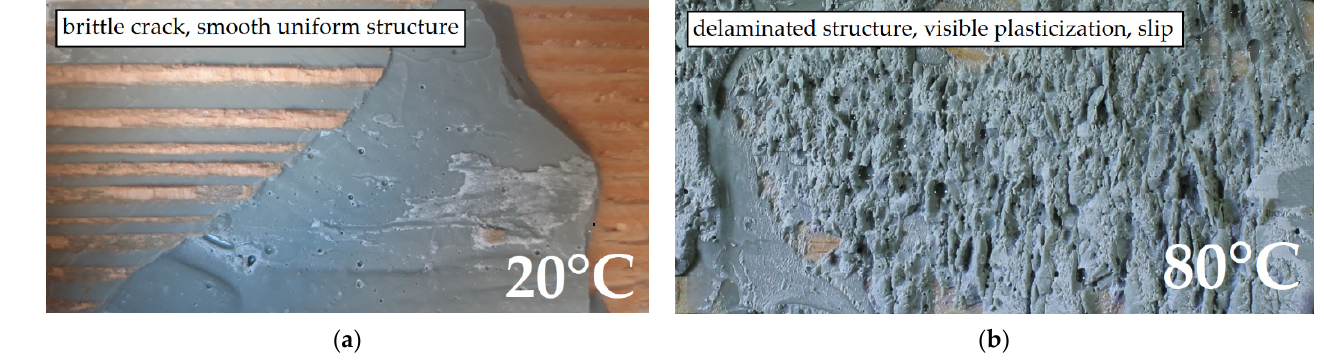
Figure 14. Failure form in the EP 2579-1 epoxy joint: ( a ) at 20 °C; ( b ) at 80 °C.